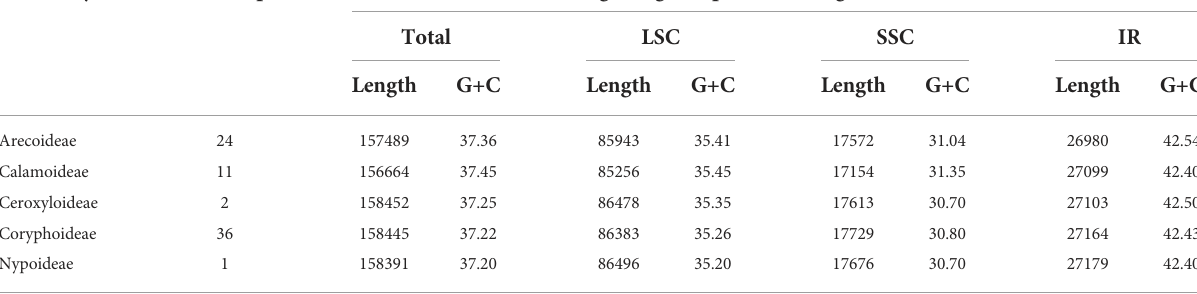
TABLE 4 Average length and G+C content for complete plastomes of the each subfamilies in Arecaceae.